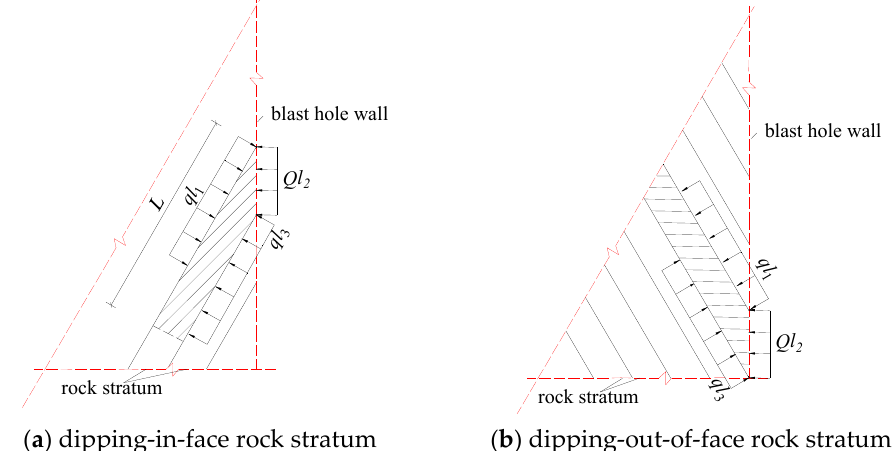
Figure 2. Schematic diagram of the force model of the cantilever beam structure of the layered rock mass with different dipping direction.